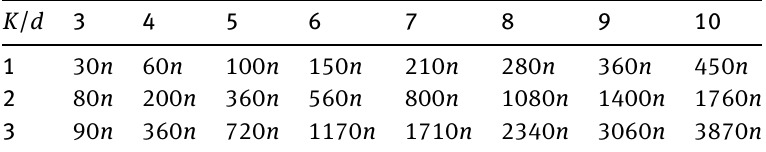
Table 1: Example of the computational cost with d (columns) and K (rows) in function of n for | B | = 1 and N k = 10 × ( k + 1) 2 . K /